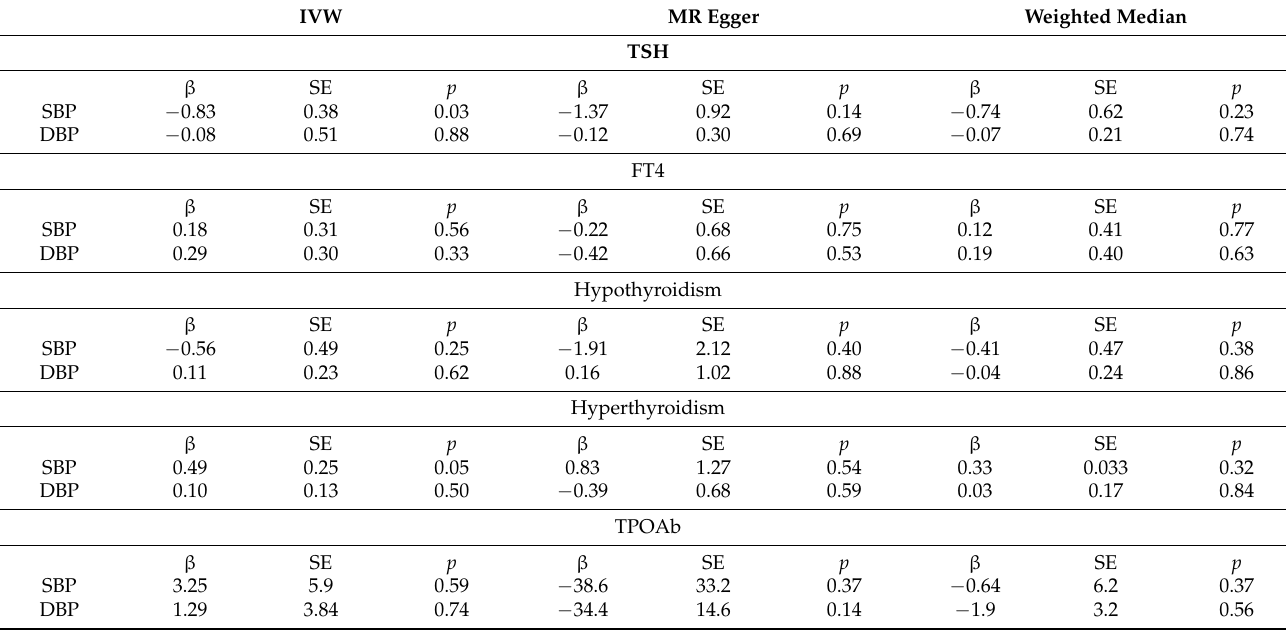
Table 1. Association of THS levels with blood pressure traits.